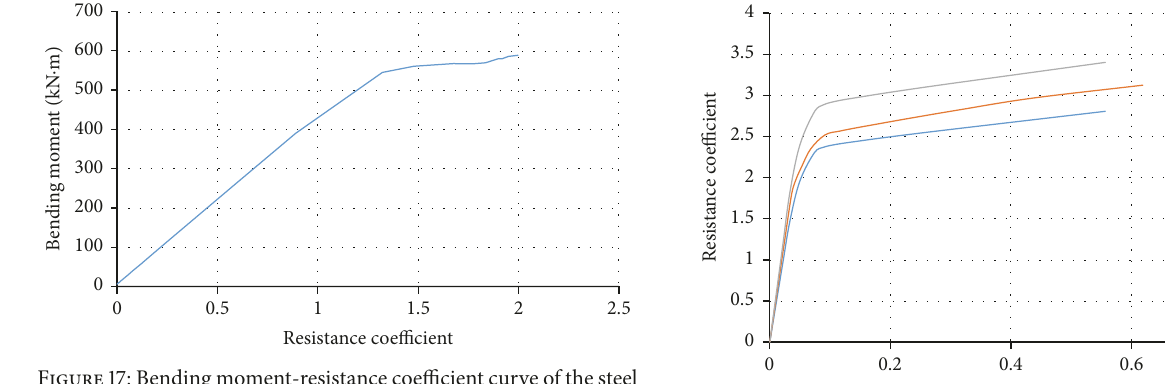
Figure 17: Bending moment-resistance coefficient curve of the steel beam connected with the removed corner column.